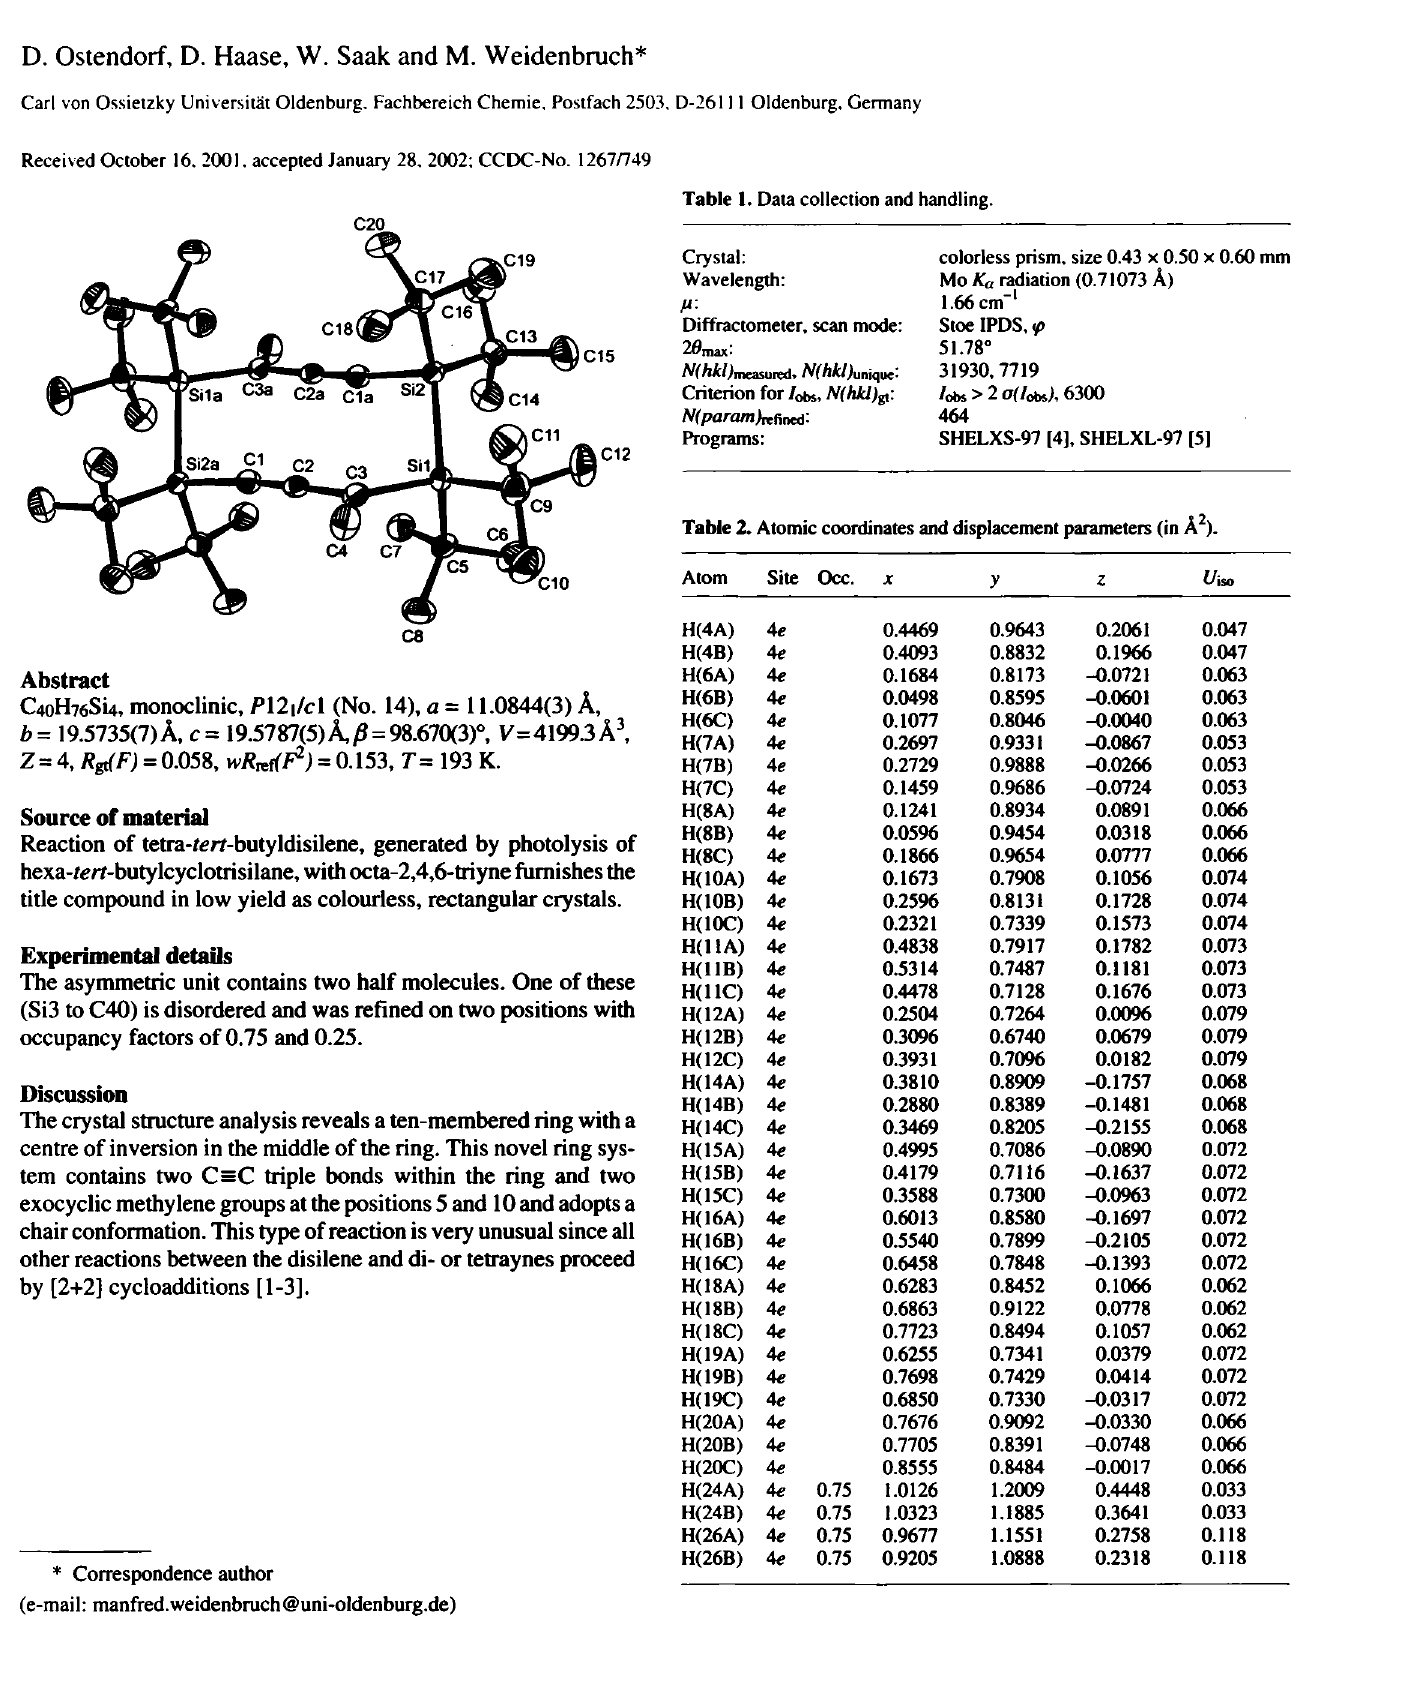
Table 2. Atomic coordinates and displacement parameters (in Â 2